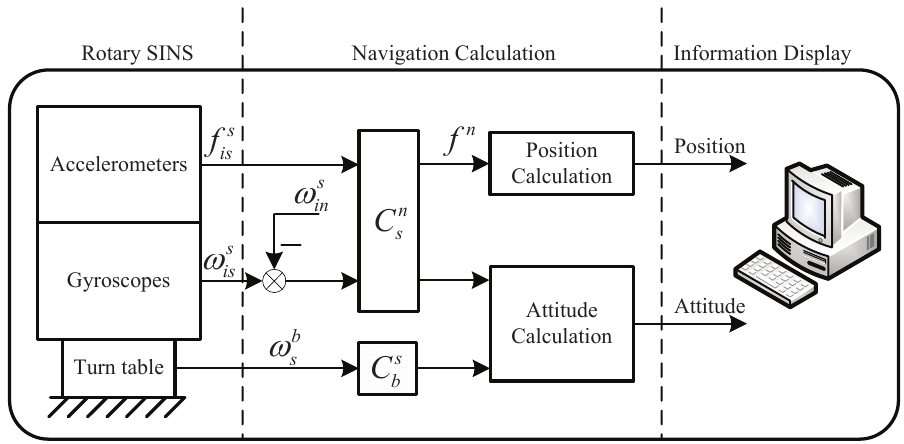
Figure 1. Schematic of the rotary strapdown inertial navigation system